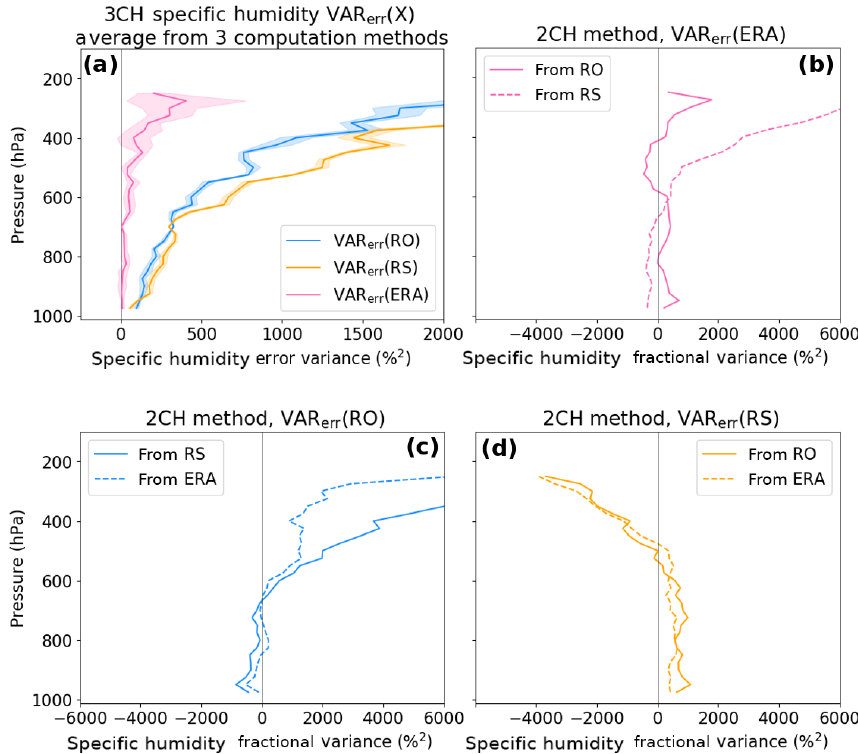
Figure 12. Estimated error variances for specific humidity: (a) results from the 3CH method for ERA (purple), RO (blue) and RS (orange). Other three panels: 2CH method estimates for ERA (b) , RO (c) and RS (d) .